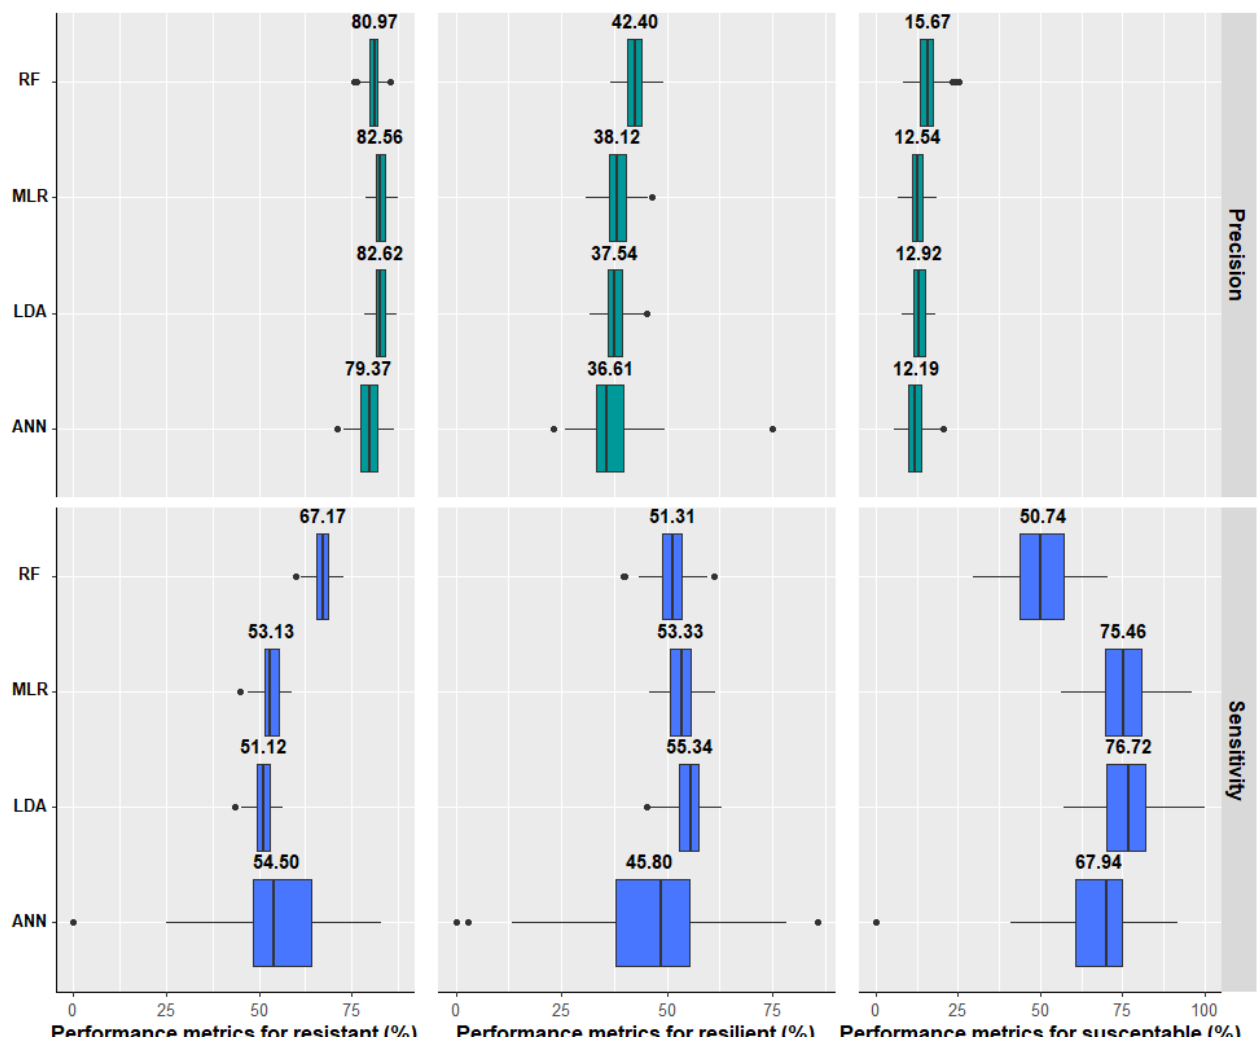
Figure 1. Precision and sensitivity for the classification of parasitic infection response (resistant, resilient, and susceptible) in sheep according to different methods (random forest—RF, multinomial logistic regression—MLR, linear discriminant analysis—LDA, and artificial neural network—ANN) trained with easy-to-measure explanatory variables. Performance metrics were computed using a 5-fold cross-validation with 20 random replicates. The left and right of the box represent first and third quartiles, respectively; the vertical line denotes the median; the value above the box is the mean; the whiskers correspond to 1.5 × interquartile distance; and the dark dots are outliers.